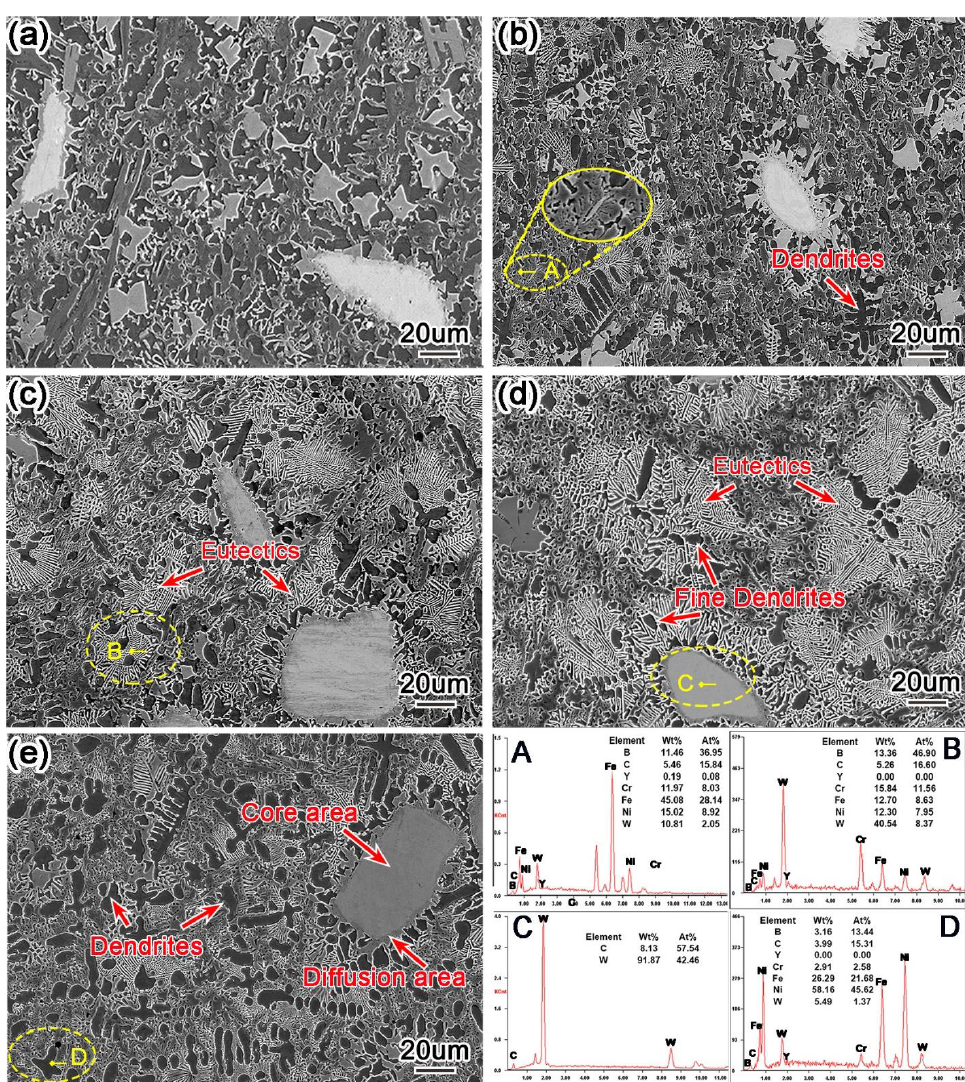
Figure 9. SEM images of Y 2 O 3 -modified Surfacing layer along with EDS maps ( a ) 0 wt.%, ( b ) 0.4 wt.%, ( c ) 0.8 wt.%, ( d ) 1.2 wt.%, and ( e ) 1.6 wt.%.